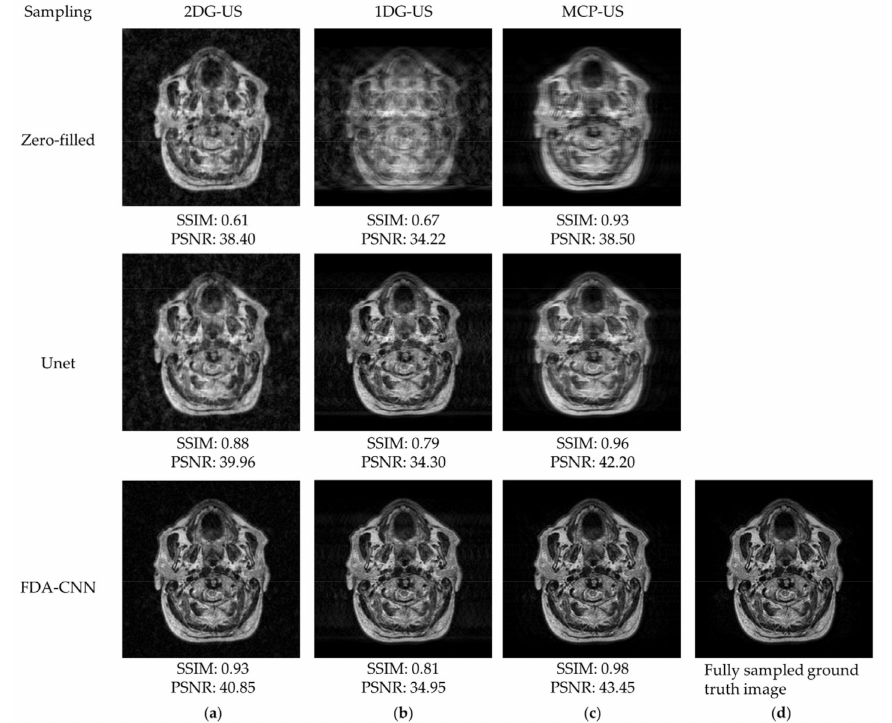
Figure 12. Reconstructed MRI images from IXI dataset (slice No. 75) using zero filling, Unet, and FDA-CNN at a sampling rate of 20%: ( a ) 2D Gaussian distribution; ( b ) 1D Gaussian distribution; ( c ) mixed center and peripheral under-sampling; ( d ) fully sampled ground truth image.